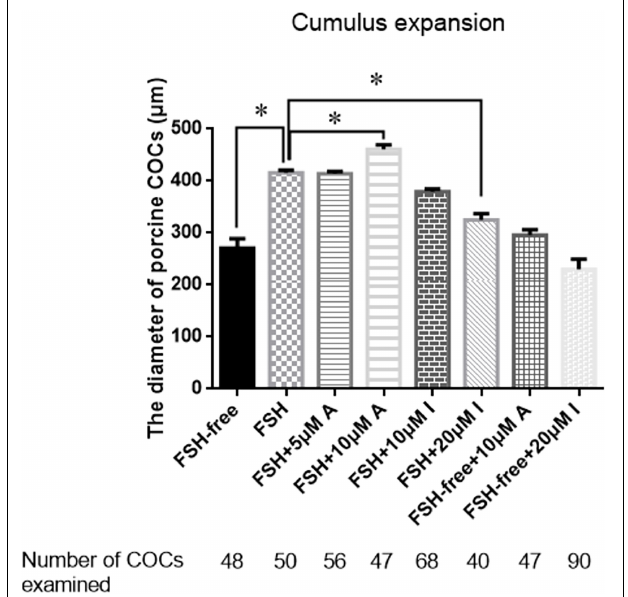
FIGURE 3 | Effects of CASR activation or inhibition on cumulus cell expansion during IVM of porcine COCs. COCs were cultured in base IVM medium supplemented with FSH (0.01 U/ml), and/or the CASR agonist NPSR-568 (5 or 10 µ M, A) and/or the CASR inhibitor NPS2390 (10 or 20 µ M, I) for 24 h. FSH group was taken as a unit. Statistically significant differences are examined by independent t -test. Data are expressed as mean ± SEM from three independent experiments (* p < 0.05). CASR, Calcium-Sensing Receptor; A, CASR agonist NPSR-568; I, CASR inhibitor